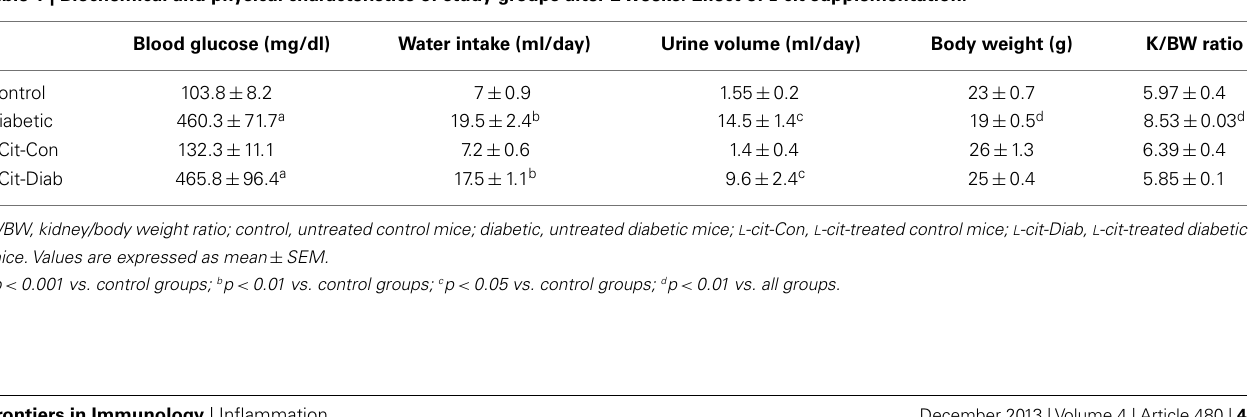
Table 1 | Biochemical and physical characteristics of study groups after 2weeks. Effect of L -cit supplementation. Blood glucose (mg/dl)